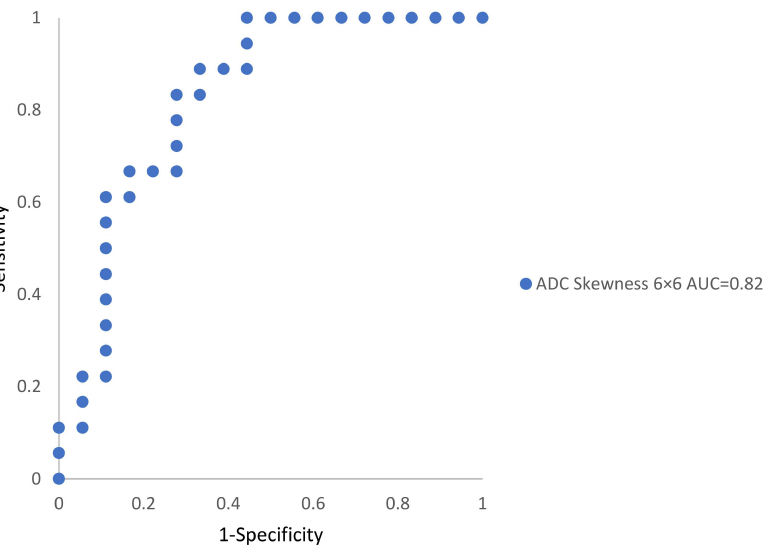
Figure 3. The best textural features from ROC curves and discernment of ROIs including significant tumors or non-tumor regions with AUC